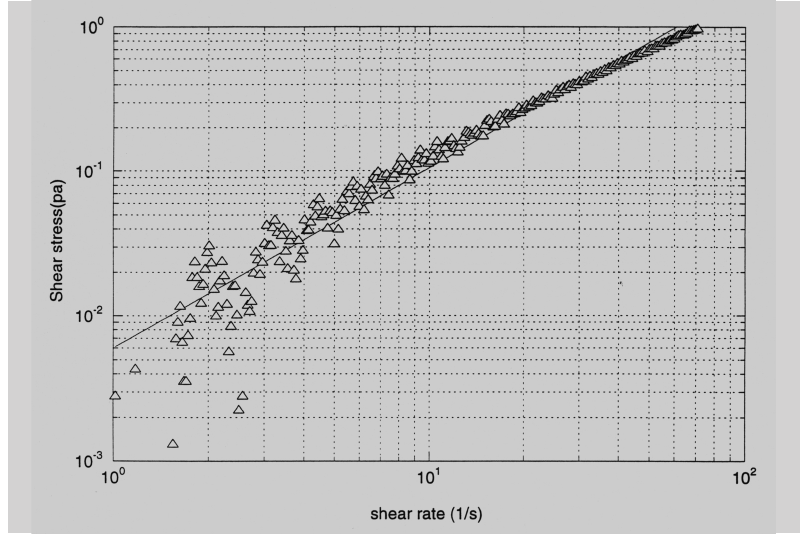
Figure 3 (left): Typical rheogram of the suspension for c = 50%. Figure 4 (right): Variation of the viscosity of the suspension versus the concentration of the solid particles. Figure 5 (bottom): Arrangement for a